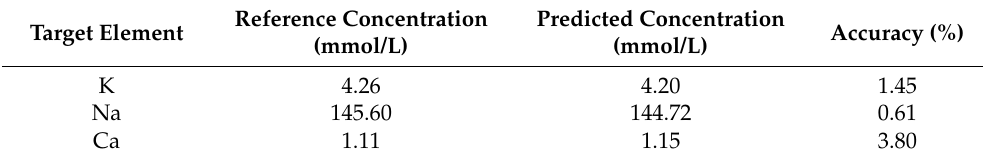
Figure 5. The quantitative analysis of elements in blood serum on glass slides. ( a ) K; ( b ) Na; ( c ) Ca. Table 1. The results for blood serum on glass slides using the test